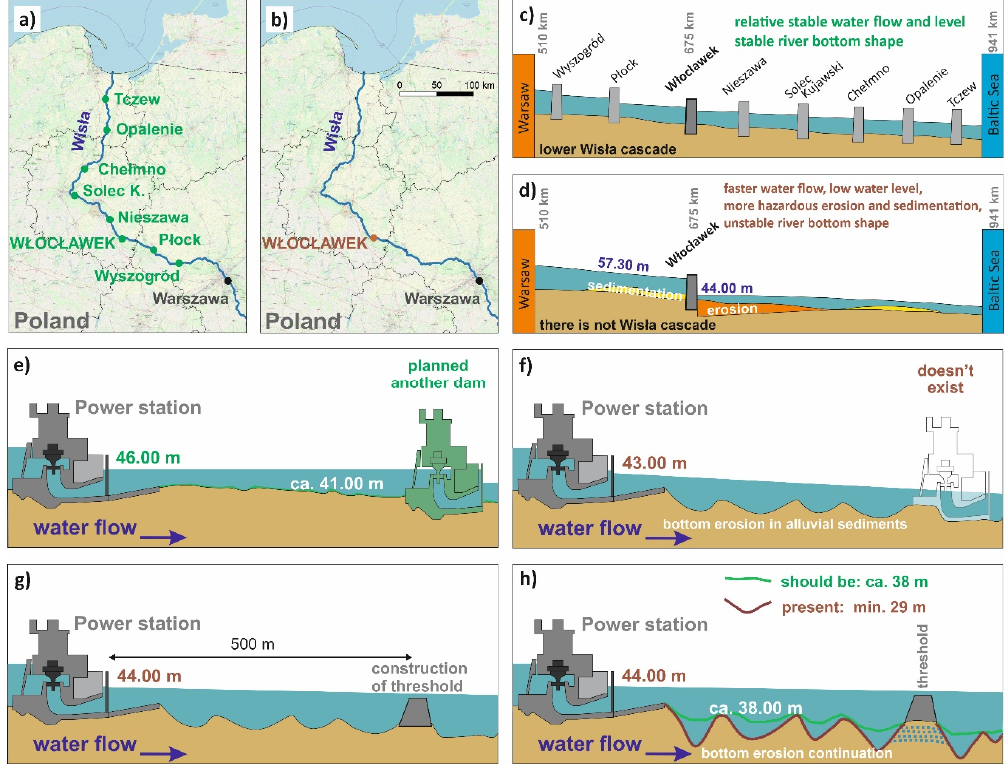
Figure 1. Cause of the problem on power plant Włocławek—motivation for research engineering-geological case of study: ( a ) Planned cascade of dams with optimal regime of sedimentation and erosion of the river bottom. ( b ) Realized dams with current problems of erosion of river bottom (only one power plant dam was constructed). ( c ) Planned dams in 1956. ( d ) Only one dam built in 1970. ( e ) Planned conditions. ( f ) Existing conditions. ( g ) Improved conditions as for river bottom erosion due to a threshold. ( h ) Erosion of the bottom continues and the threshold is endangered.